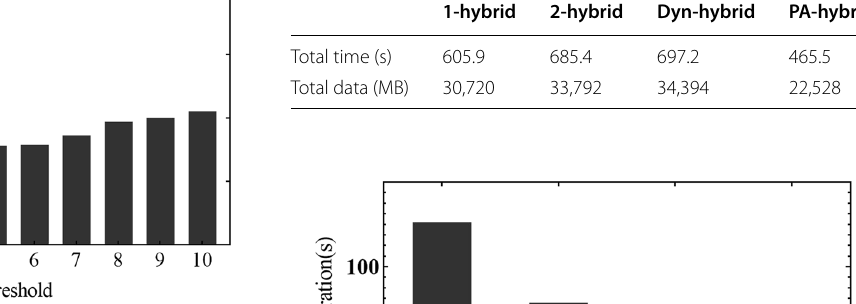
Fig. 10 Data transferred using post-copy based on different fixed switching thresholds when migrating the increasing workloads of Memcached